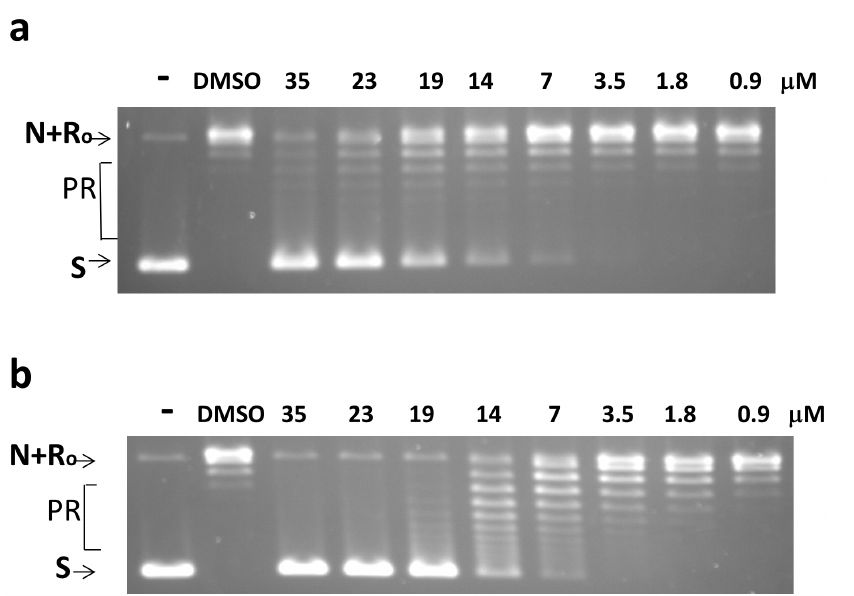
Figure 5. Inhibition of Relaxation activity of Y.pestis topoisomerase I by anziaic acid in the presence of different concentrations of Mg 2 + . Assays were carried out in the presence of 0.0025% Tween 20 and MgCl 2 concentration of 0.5 mM (a) or 6 mM (b). -: no enzyme control. Anziaic acid is present at the concentration indicated.